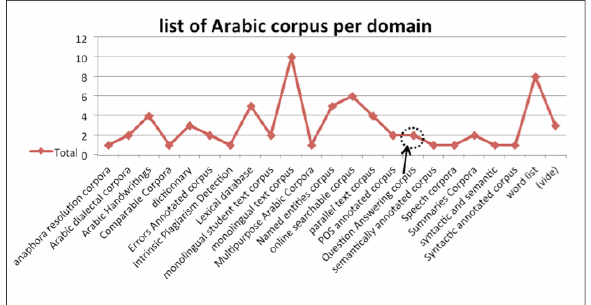
Figure 3. List of Arabic corpus per